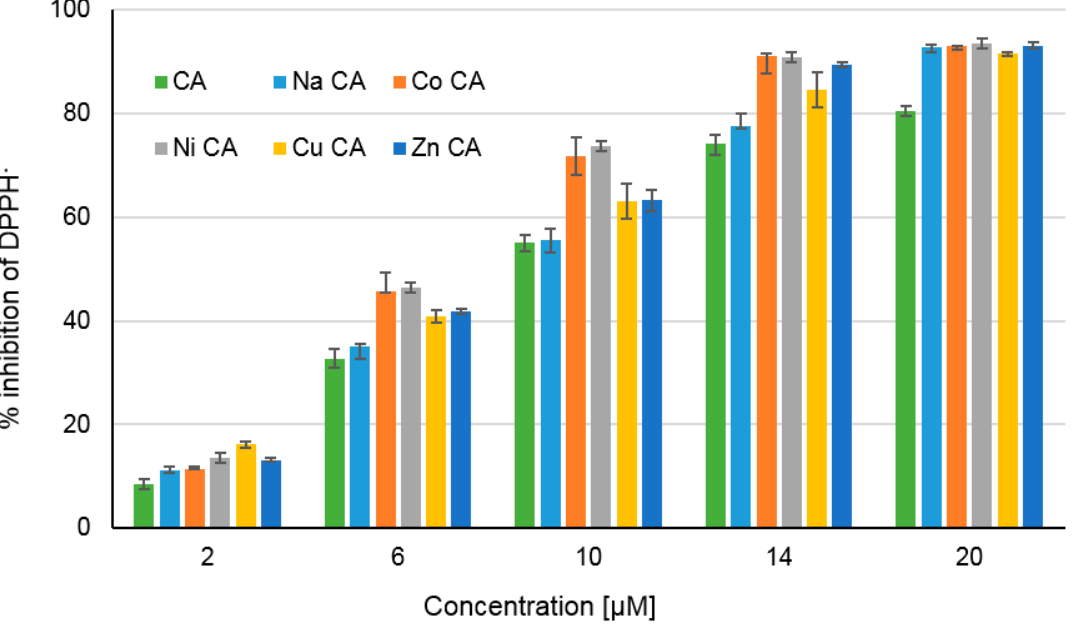
Figure 8. The percentage of DPPH inhibition by cichoric acid (CA) and its metal compounds in the range of their concentration 2–20 μ M.